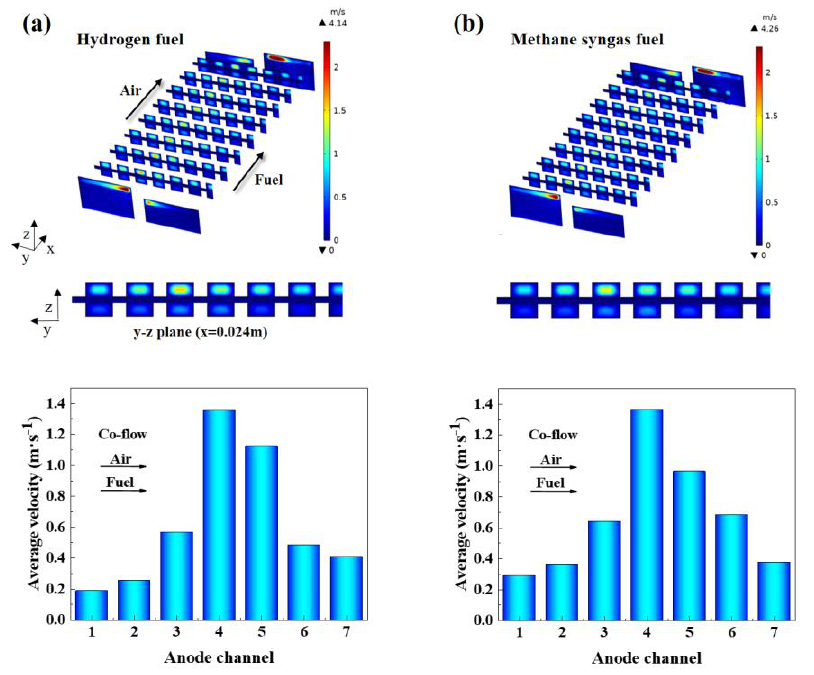
Figure 4. Velocity( m · s −1 ) distributions inside SOFC for: ( a ) hydrogen fuel; ( b ) methane syngas Figure 4. Velocity(m · s − 1 ) distributions inside SOFC for: ( a ) hydrogen fuel; ( b ) methane syngas fuel.